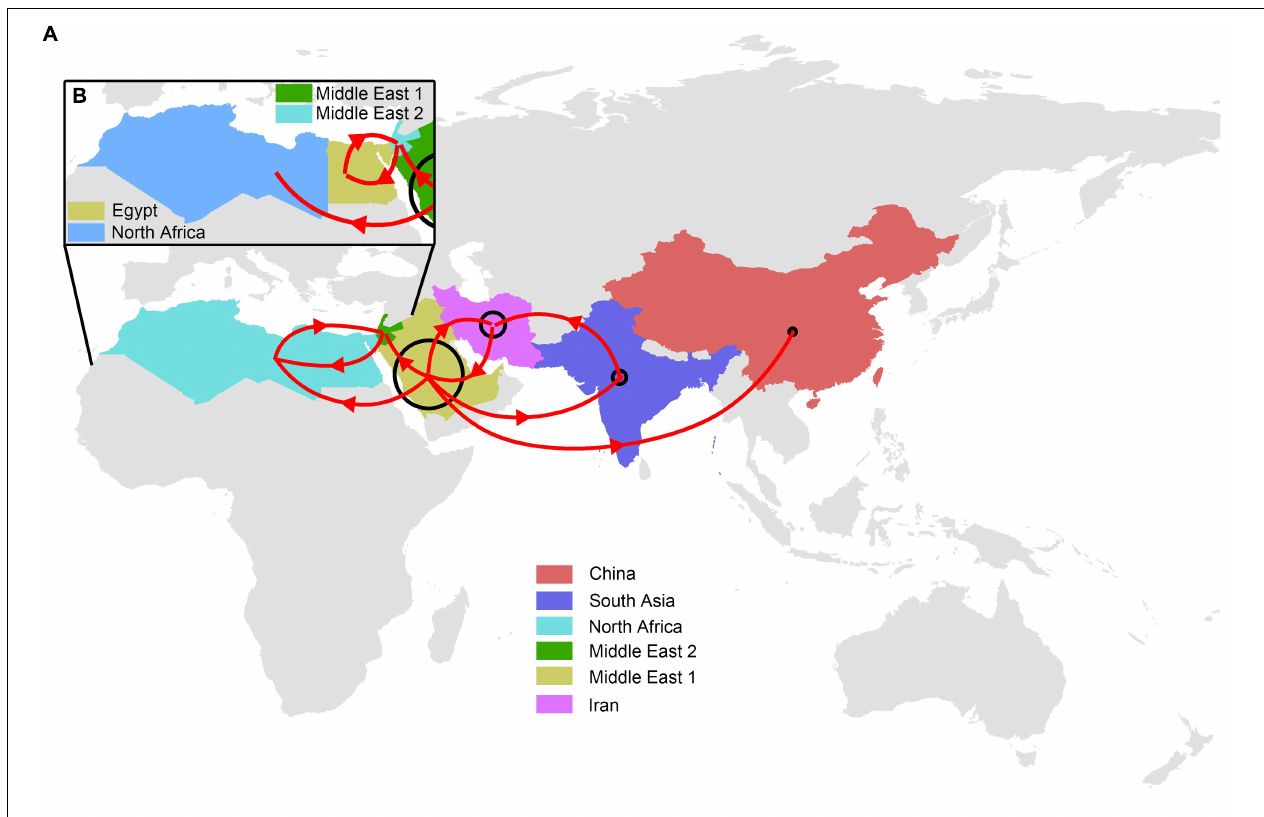
FIGURE 2 | Migration pathways of global LPAI H9N2 viruses. (A) Locations were assigned to six regions: Middle East 1 (Saudi Arabia, Emirates and Iraq), Middle East 2 (Jordan, Lebanon and Israel), North Africa (Egypt, Morocco, Libya, Tunisia and Algeria), China, Iran and South Asia (Bangladesh, India and Pakistan). (B) Egypt was designated as a separate region from North African countries (Morocco, Libya, Tunisia and Algeria). Lines with arrows illustrate main migration routes. The size of the circle indicates relative chance of a region acting as a migration source. The color of each region is consistent with those shown in Figure 1